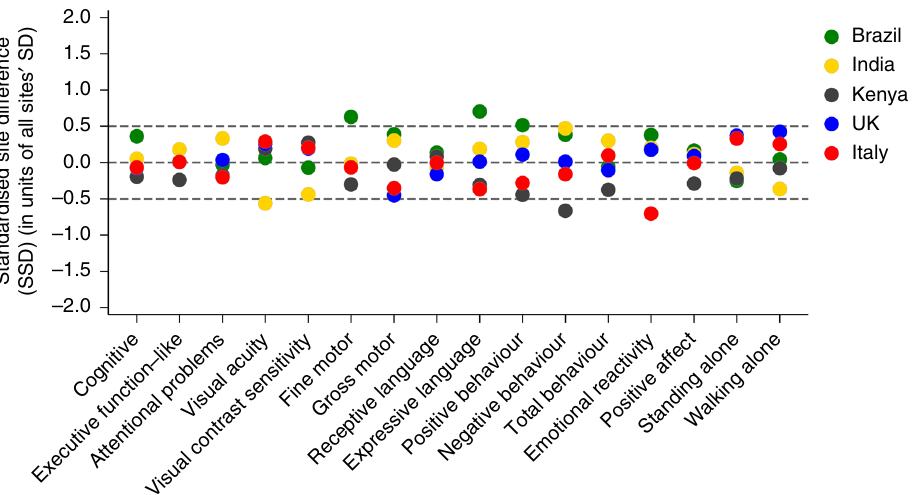
Fig. 2 Standardised site difference for mean scores of individual domains of the INTERGROWTH-21 st Project Neurodevelopment Assessment, Cardiff tests and age of achievement of two WHO gross motor development milestones. The standardised site differences calculated as the site mean of each domain minus the mean for all sites combined divided by the SD of all sites together, adjusted by the age at the time of assessment and sex. Results are shown as: Brazil (green), India (yellow), Kenya (brown), UK (blue) and Italy (red). Sample size according to domain and study site is given in Supplementary Table values of the 45 comparisons outside the pre-speci fi ed SSD cut-off point of ±0.5 (Brazilian site for fi ne motor: SSD 0.63 and Indian site for visual acuity: SSD − 0.56).